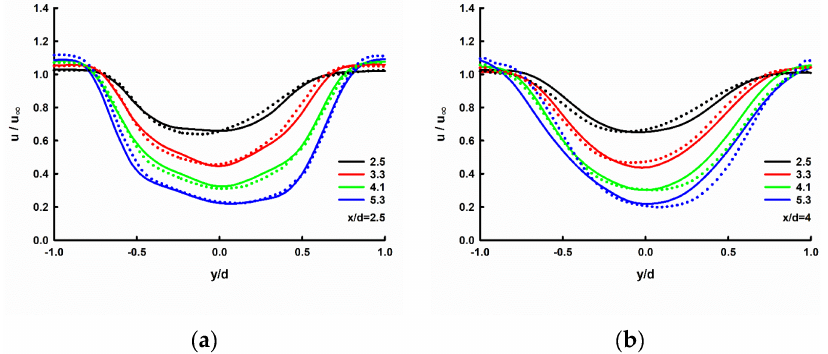
Figure 14. Time-averaged normalised stream-wise wake velocity along − 0.75 d ≤ y/d ≤ +0.75 d for different tip speed ratios at near-wake distances. ( a ) x/d = 2.5; ( b ) x/d = 4. Instantaneous normalised stream-wise wake velocity profiles are represented using dotted lines.